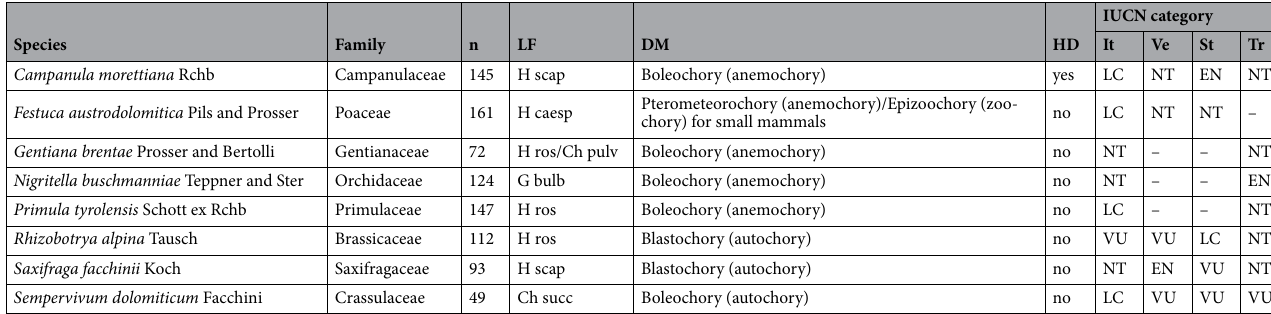
Table 1. Life-history traits and conservation assessment for the eight studied species. For each species we reported the family, the life form (LF; H scap = scapose hemicryptophyte, H caesp = bushy hemicryptophyte, H ros = rosulate hemicryptophyte, Ch pulv = pulvinate chamaephyte, G bulb = bulb geophyte, Ch succ = succulent chamaephyte), the dispersal mode (DM), the inclusion in the Annex IV of the European Habitats Directive 92/43/EEC (HD; yes or no) and the IUCN category both at national level 45,46 (It) and at regional level 42,47,48 (Ve = Veneto, St = South-Tyrol and Tr =